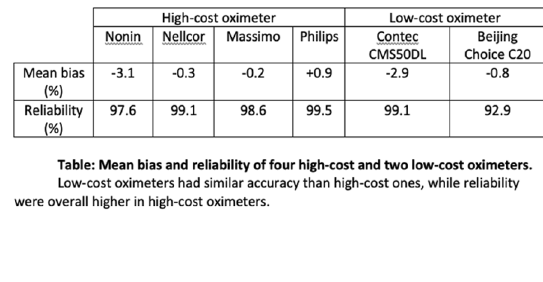
Figure: impact of oximeter on oxygen management to maintain a SpO 2 target between 92 and 96% (left panel) and impact with adapted SpO 2 target to the oximeter (right